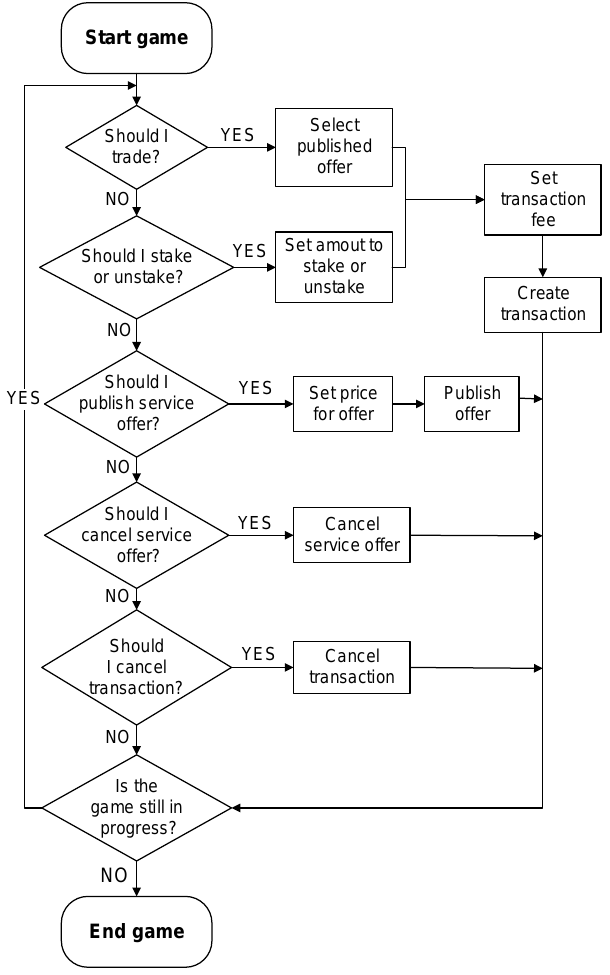
Figure 3. Flowchart of the player decision-making